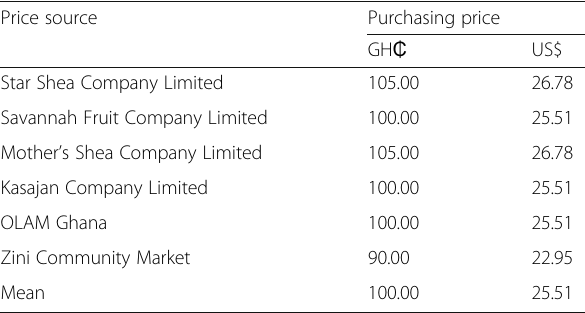
Table 3 Purchasing price per bag of shea kernel in the Guinea savanna zone of Ghana